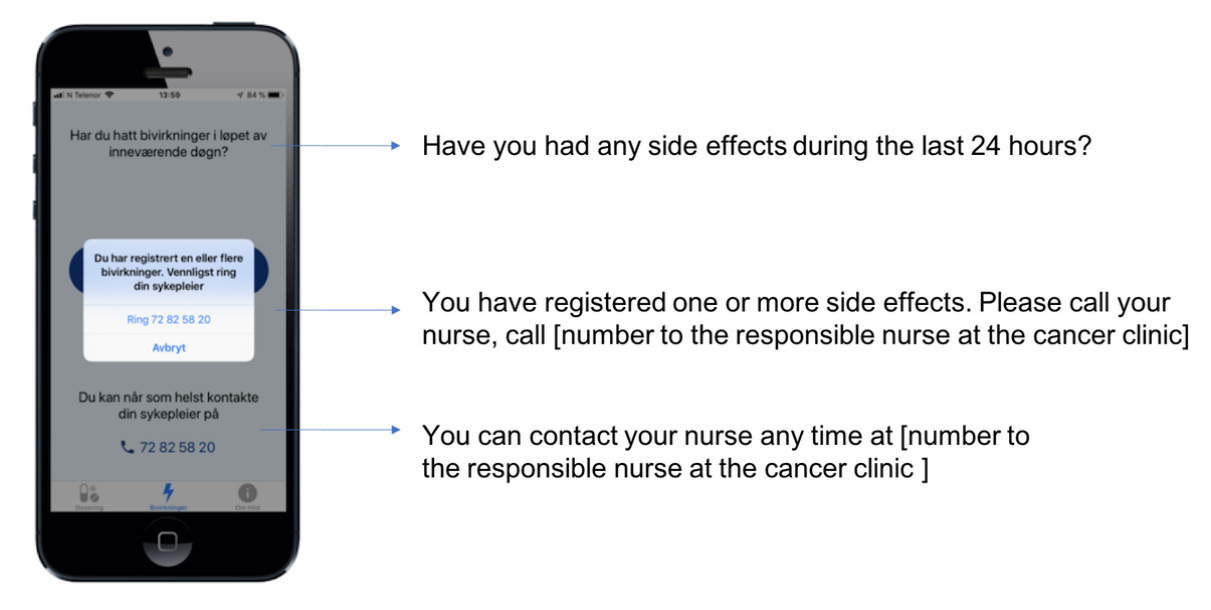
Figure 2. Features of the app for supporting management and reporting of side